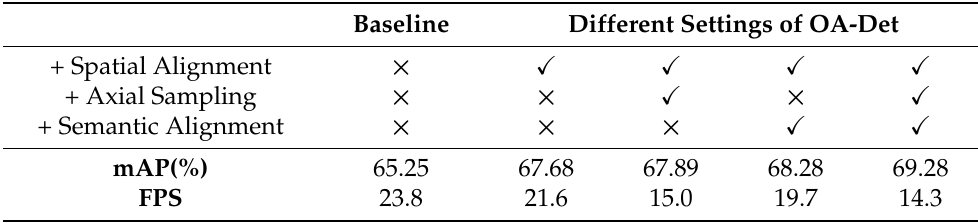
Table 1. Evaluation of different components: ’ (cid:88) ’ indicates that the component is added on the basis of the baseline, and ’ × ’ indicates that the component is not enabled. Baseline Different Settings of OA-Det + Spatial